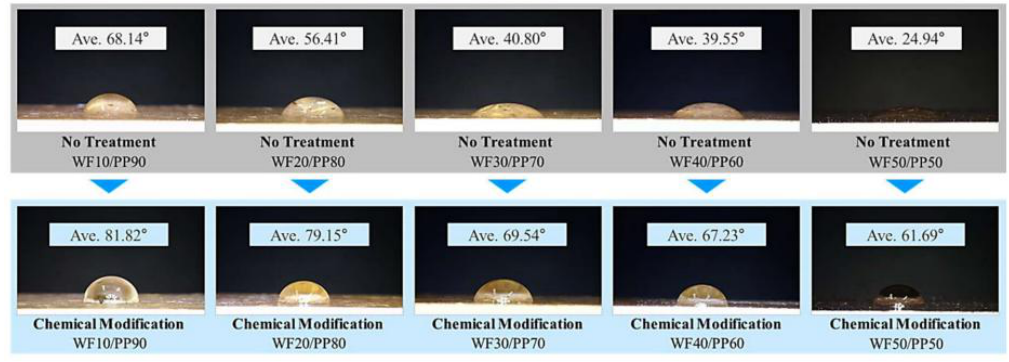
Figure 14. Contact angle measurements of chemically modified and untreated wood-plastic composite injection-molded ASTM